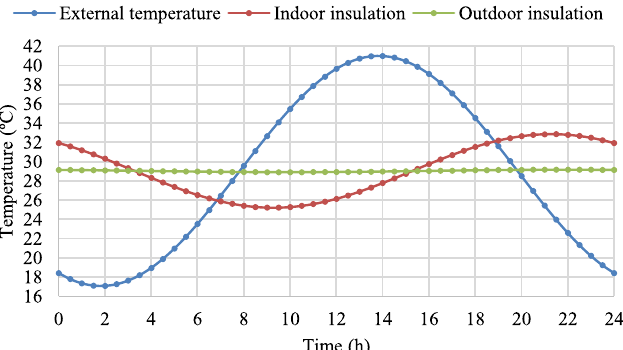
Fig. 6. Variation of inner surface temperature in a wall with outdoor and indoor thermal